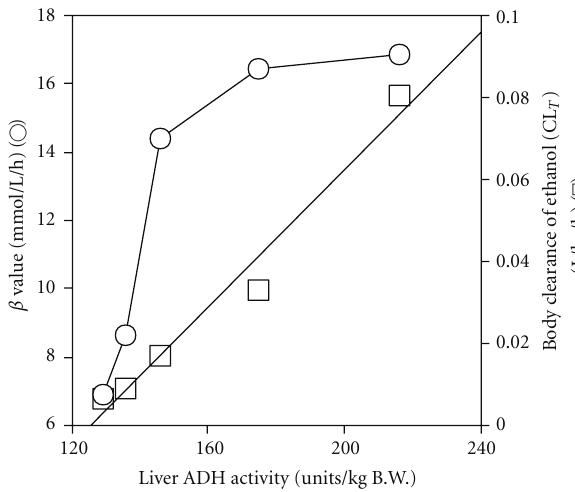
Figure 6: Correlation of β and body clearance (CL T ) with liver ADH activity. β value ( (cid:2) ) was from Figure 2. CL T value ( (cid:2) ) was the reciprocal of the normalized AUC in Figure 2. Liver ADH activity was from Figure 3(a).